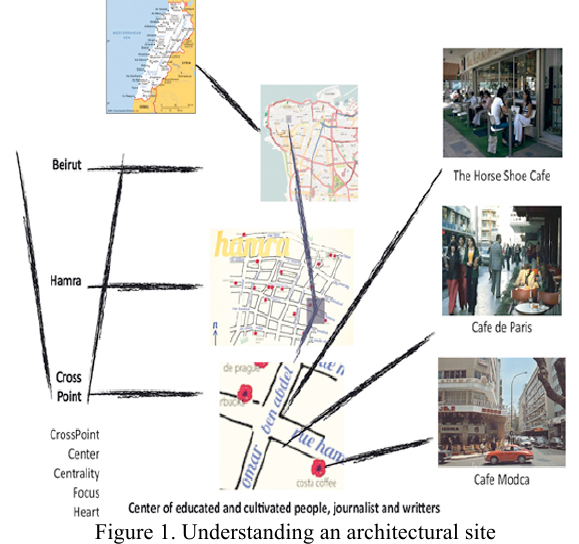
Figure 1. Understanding an architectural site